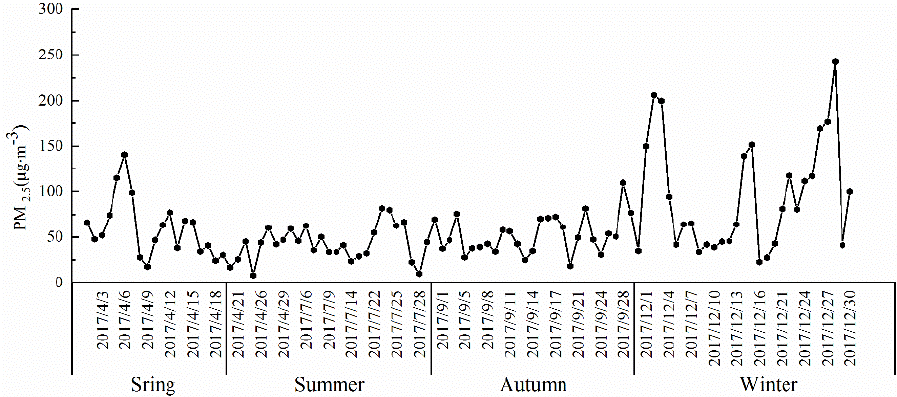
Figure 2. Regularity of mass concentration of PM 2.5 during different sampling periods in Xinxiang city, China.